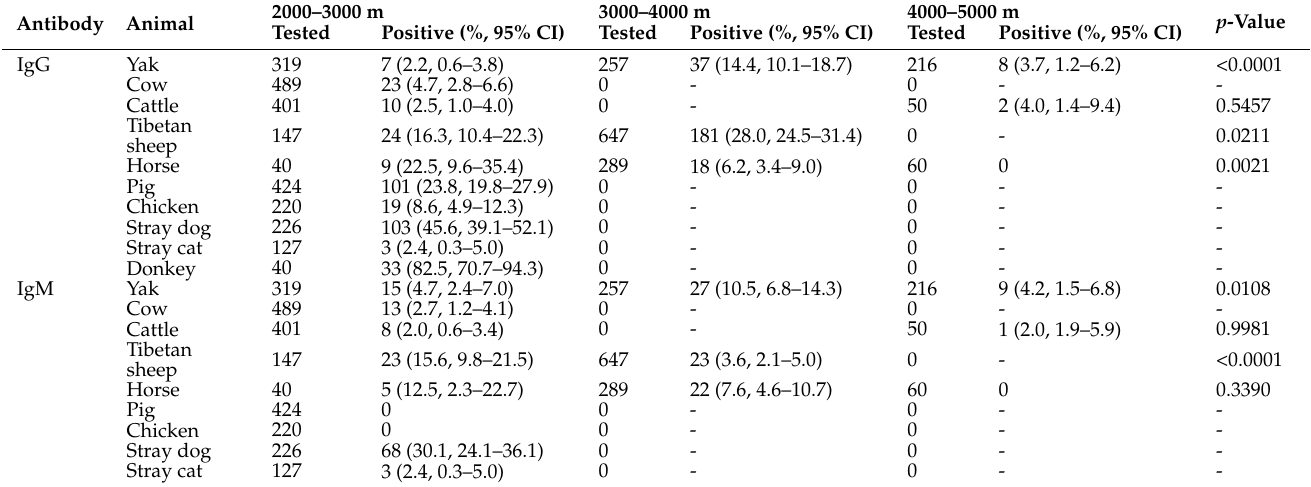
Table 3. Analysis of influence of altitude on positivity of Anaplasma IgG and IgM